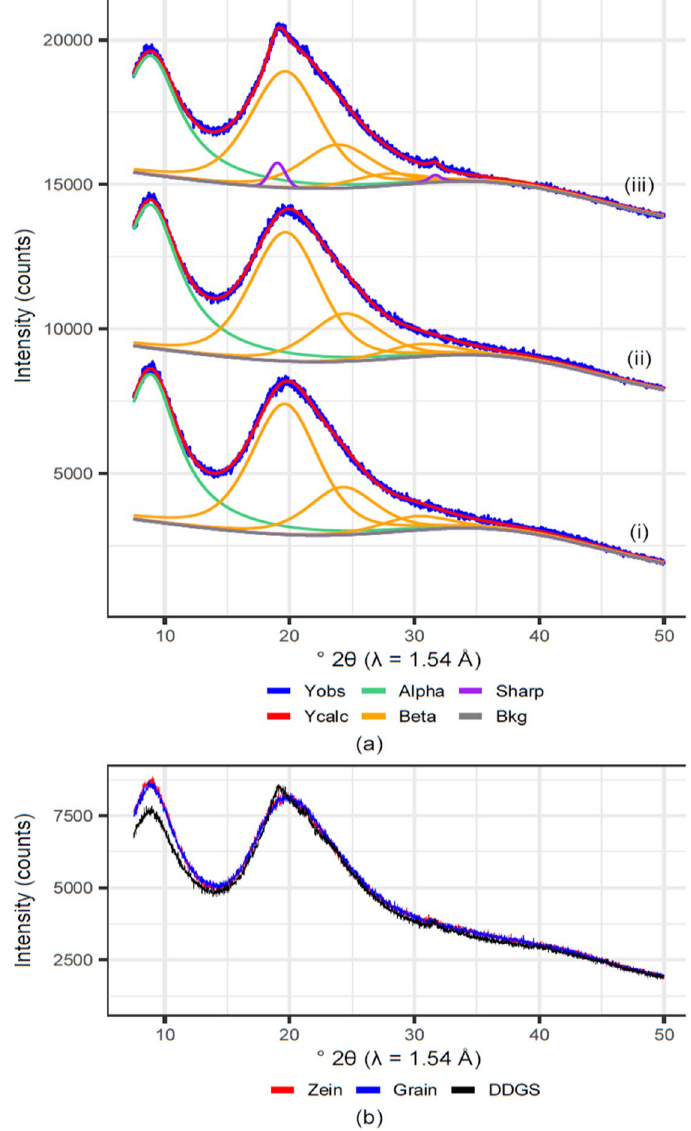
Figure 3. X-ray diffraction patterns, showing fits for Zein ( a-i ), grain kafirin ( a-ii ), and kafirin from dried distillers grain with solubles (DDGS) ( a-iii ). ( b ) The increased intensity at 20° 2θ, and increased 20° to 9° 2θ area ratio in DDGS kafirin compared to grain kafirin and